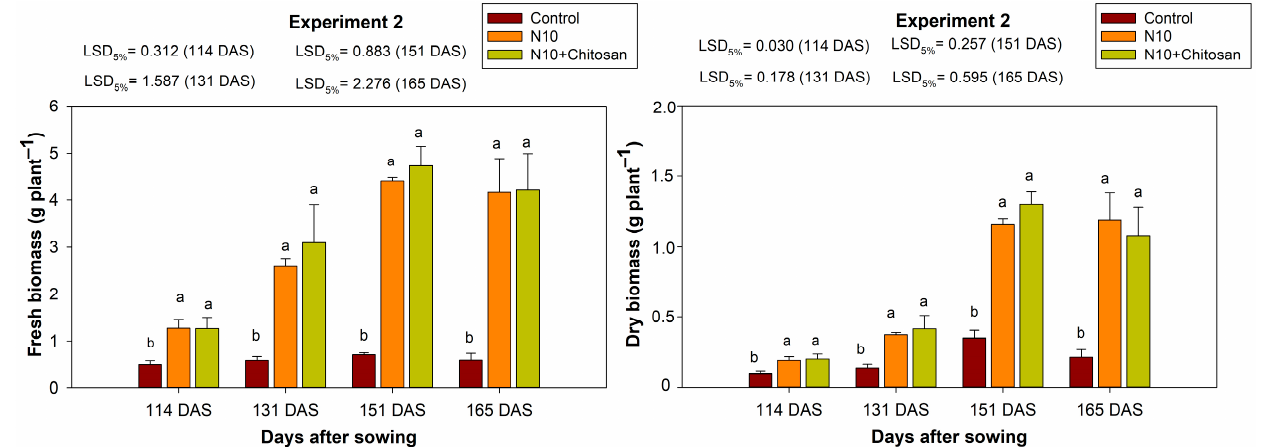
Figure 7. Fresh and dry biomass (g plant − 1 ) of bristly oxtongue as affected by nitrogen fertilization and chitosan application. For each sampling date, bars followed by the same letters were not shown to significantly differ with Fisher’s least significant difference (LSD) test. Errors bars show the Standard Error values. Final measurement (source of variation: treatments): Fresh biomass: Fvalue = 12.787, p = 0.018, DF (degrees of freedom) = 2 and Dry biomass: Fvalue = 12.453, p = 0.019, DF = 2.